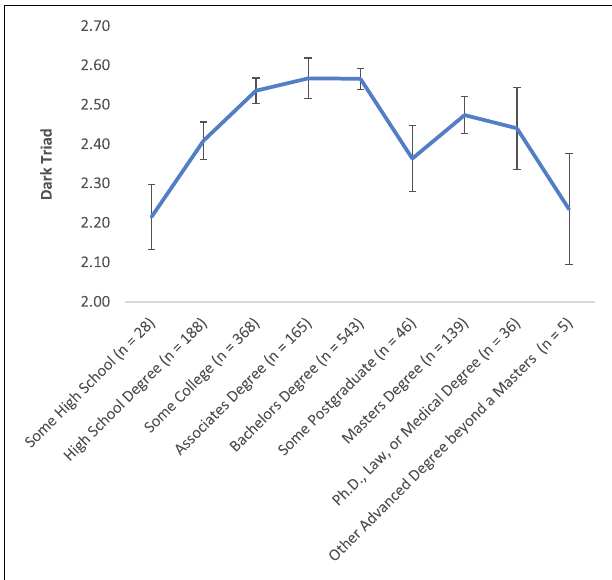
FIGURE 5 | Curvilinear relationship between education and dark triad in the total sample. N = 1518.